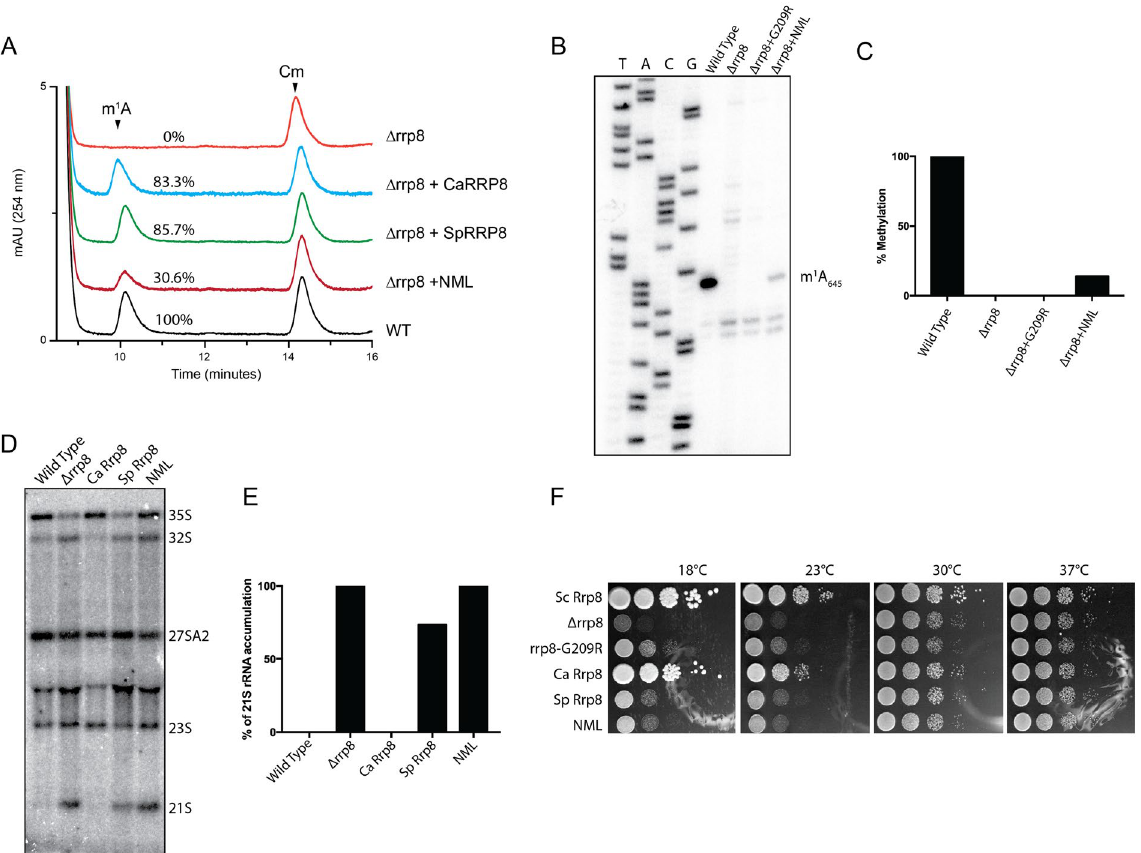
Figure 2. Heterologous expression of RRP8 homologs and biochemical and phenotypic analysis. ( A ) Overlaid RP-HPLC chromatograms of the nucleosides derived from fragments isolated using mung bean nuclease assay, containing m 1 A 645 (Sc-Oligo645) isolated from wild-type (WT), deletion mutant ( Δ rrp8 ) or deletion mutant strains expressing homologs of RRP8 (CaRRP8 for C . albicans Rrp8, SpRRP8 for S . pombe Rrp8 and NML for H . sapiens Rrp8/NML). ( B ) Primer extension analysis of Δ rrp8 , the loss of methylation mutant rrp8 G209R and the heterologous expressed human homolog NML. The presence of m 1 A at position 645 in the 25S rRNA from the wild-type cells led to a strong stop. The expression of the human homolog NML in the deletion mutant of RRP8 of S . cerevisiae also led to a stop at this position to an extent of about 40% compared with S . cerevisiae wild-type. ( C ) Percent methylation was quantified from the intensity of primer extension stop (panel B) using ImageJ software (http://imagej.nih.gov/ij/). ( D ) Northern blot analysis of RRP8 homologs expressed in S . cerevisiae . 5 µ g of isolated total RNA was separated on an 1.2% agarose-gel and subsequently blotted onto a Hybond H + nylon membrane. The membrane was hybridized with radioactive ( 32 P)-labeled probes against the internal transcribed spacer 1 (ITS1) (region between cleavage sites A 2 -A 3 ). ( E ) Percent of 21S rRNA accumulation in panel D was quantified using ImageJ software. ( F ) Ten-fold dilutions of strains expressing RRP8, RRP8 homologs or catalytically-defective mutants. Cells spotted onto solid YEPD plates were incubated at four different temperatures illustrating the cold temperature sensitive phenotype of Δ rrp8 . The differences in the methylation and complementation of Rrp8 homologs of other fungal species and human cells are likely due to sequence specificities that may influence how efficiently a heterologous protein is assembled within the ribosome assembly machinery of the host cell. For example, the S . pombe protein may be incorporated in maturing subunits sufficiently well to restore methylation but not well enough to suppress the RNA cleavage defect, while the C . albicans protein may be recruited to pre-ribosomes more efficiently, allowing it to suppress both